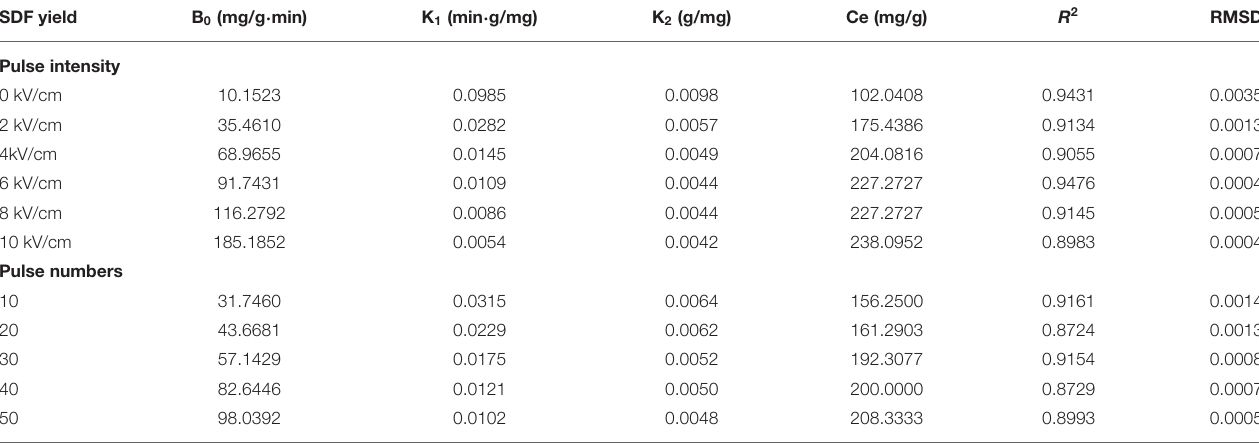
TABLE 1 | The kinetic parameters of Peleg’s model for SDF and comparison of experimental and calculated